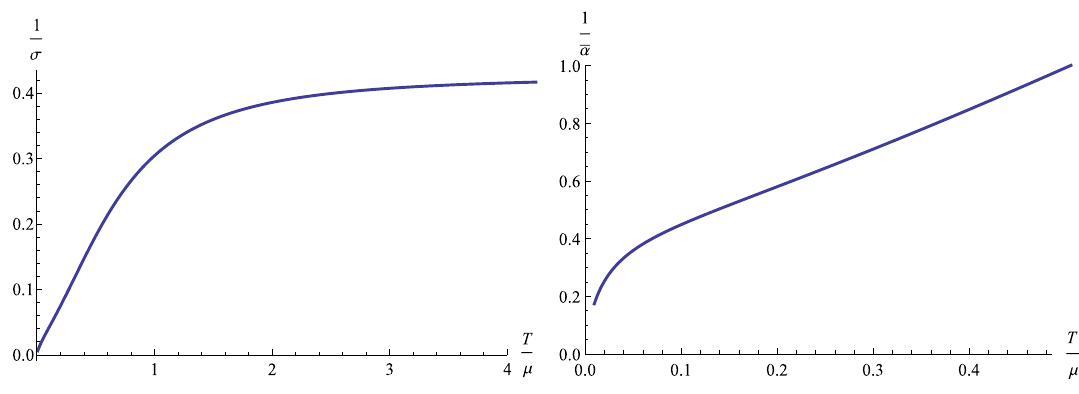
Figure 5 . Resistivites 1 =(cid:27) and 1 = (cid:22) (cid:11) as a function of the